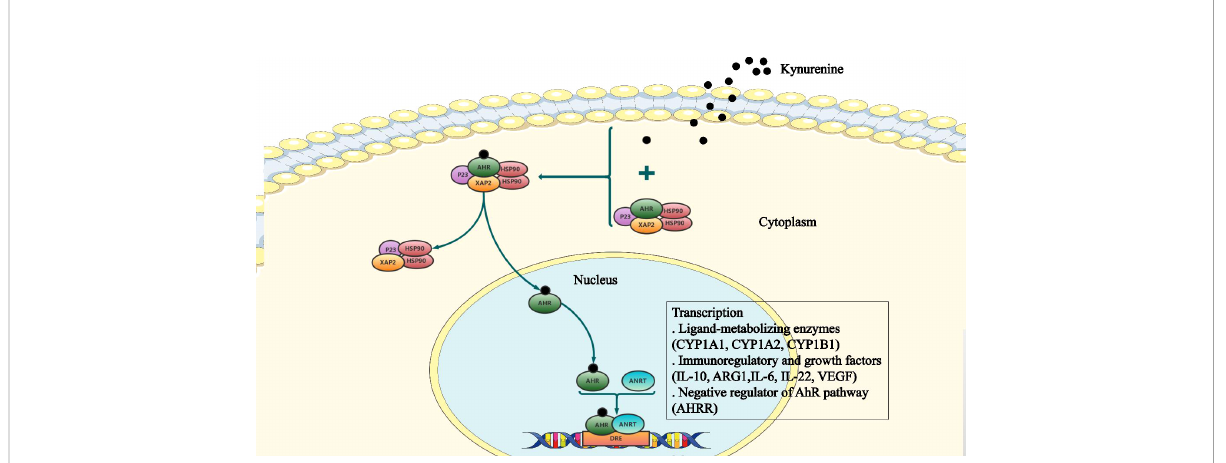
FIGURE 2 The cellular AhR signaling pathway. The aryl hydrocarbon receptor (AhR) binds to a complex of Hsp90, X-associated protein-2 (XAP2), and P23, which is present in the cytoplasm in a dormant state. Following ligand binding, AhR undergoes conformation changes, the nuclear localization signal (NLS) is exposed, and Hsp90 is released from the complex. Subsequently, AhR forms a heterodimer with the AhR nuclear translocator (ARNT). This heterodimer binds to the xenobiotic response element (XRE) to alter expression of downstream target